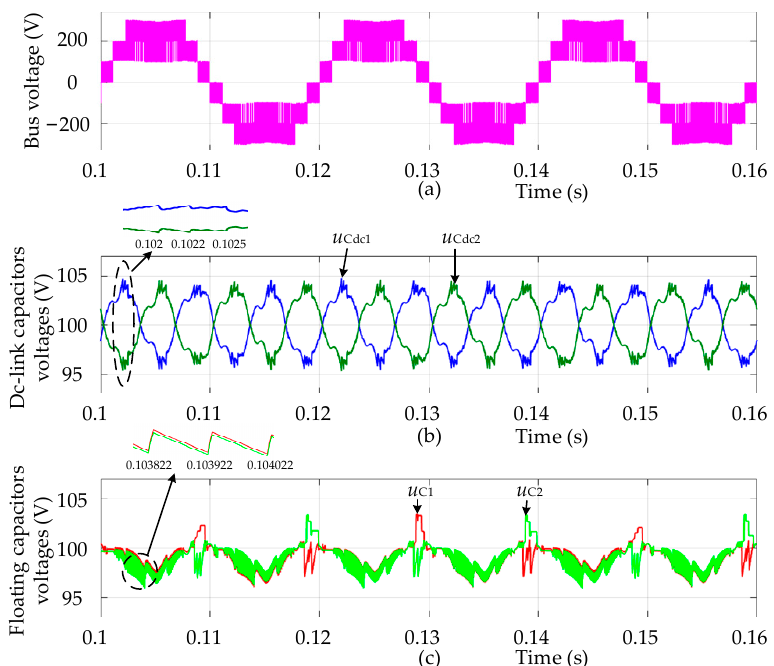
Figure 7. ( a ) The bus voltage, ( b ) DC-link capacitor voltages and ( c ) floating capacitor voltages of the A-phase under the resistive–inductive load condition.